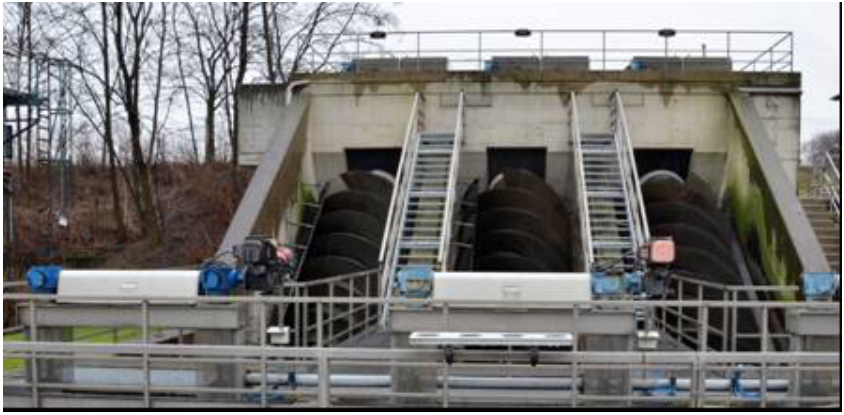
Figure 19. View of the pump station of the WWTP in Bottrop, Germany (by permission of A. N.